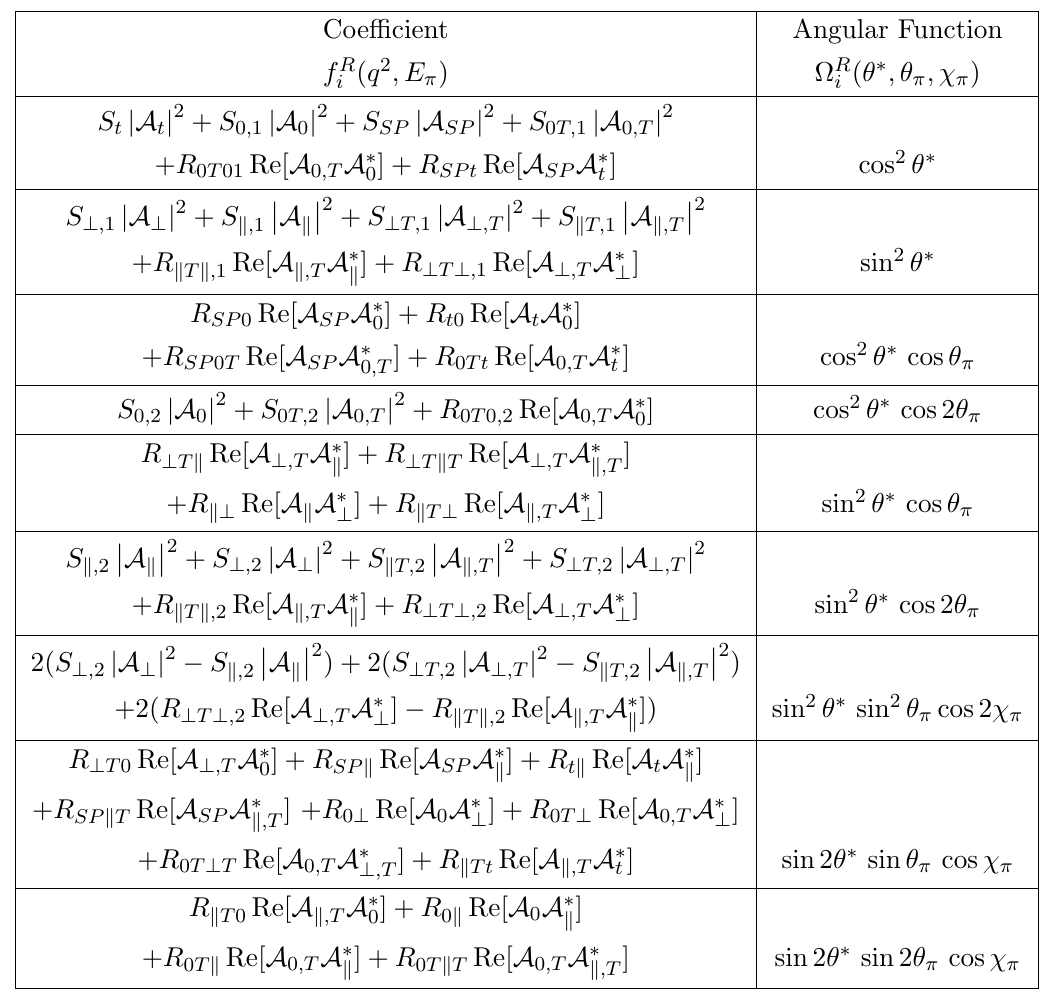
Table 2 . Contributions of N S These terms are